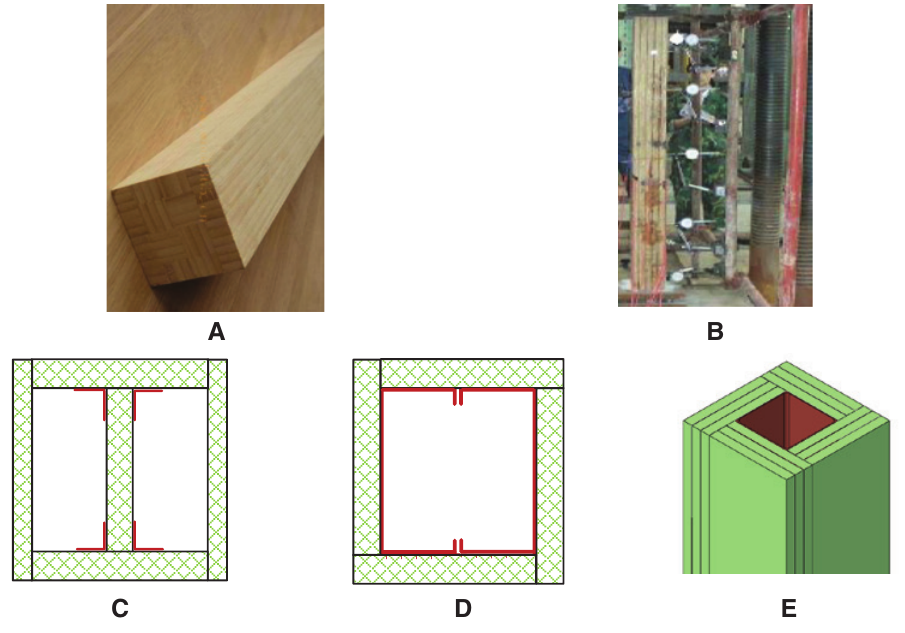
Figure 2: Laminated bamboo columns. (A) Laminated bamboo column, (B) bamboo-plywood composite column, (C) box-type bamboo-plywood composite column developed by Liu et al., (D) bamboo-plywood composite column developed by Li et al., and (E) bamboo-plywood composite column developed in this